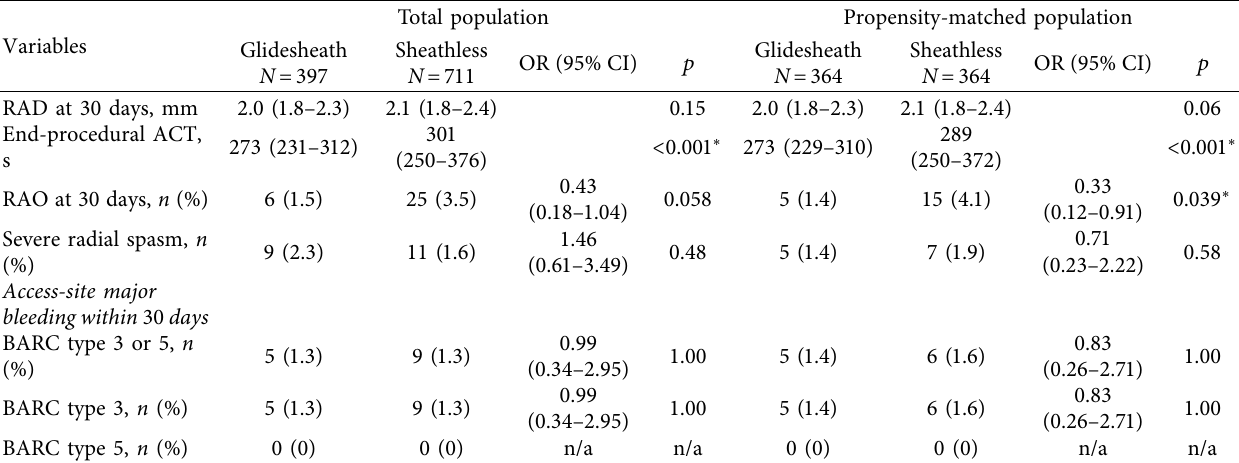
Table 4: Periprocedural access-site complications.